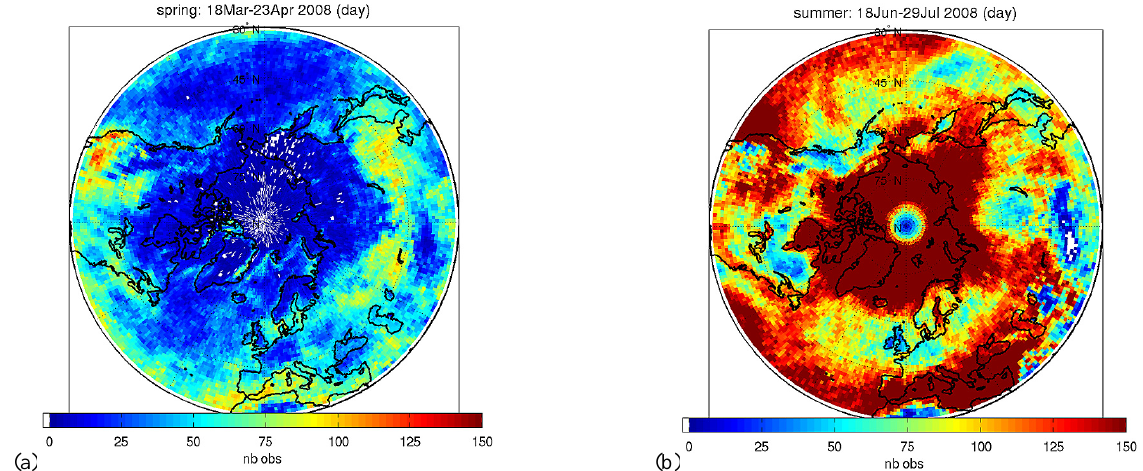
Fig. 2. Distribution of the number of daytime IASI data gridded on 1 ◦ × 1 ◦ using the RMS and bias filter for the spring (a) and summer (b) POLARCAT campaigns. White areas indicate no